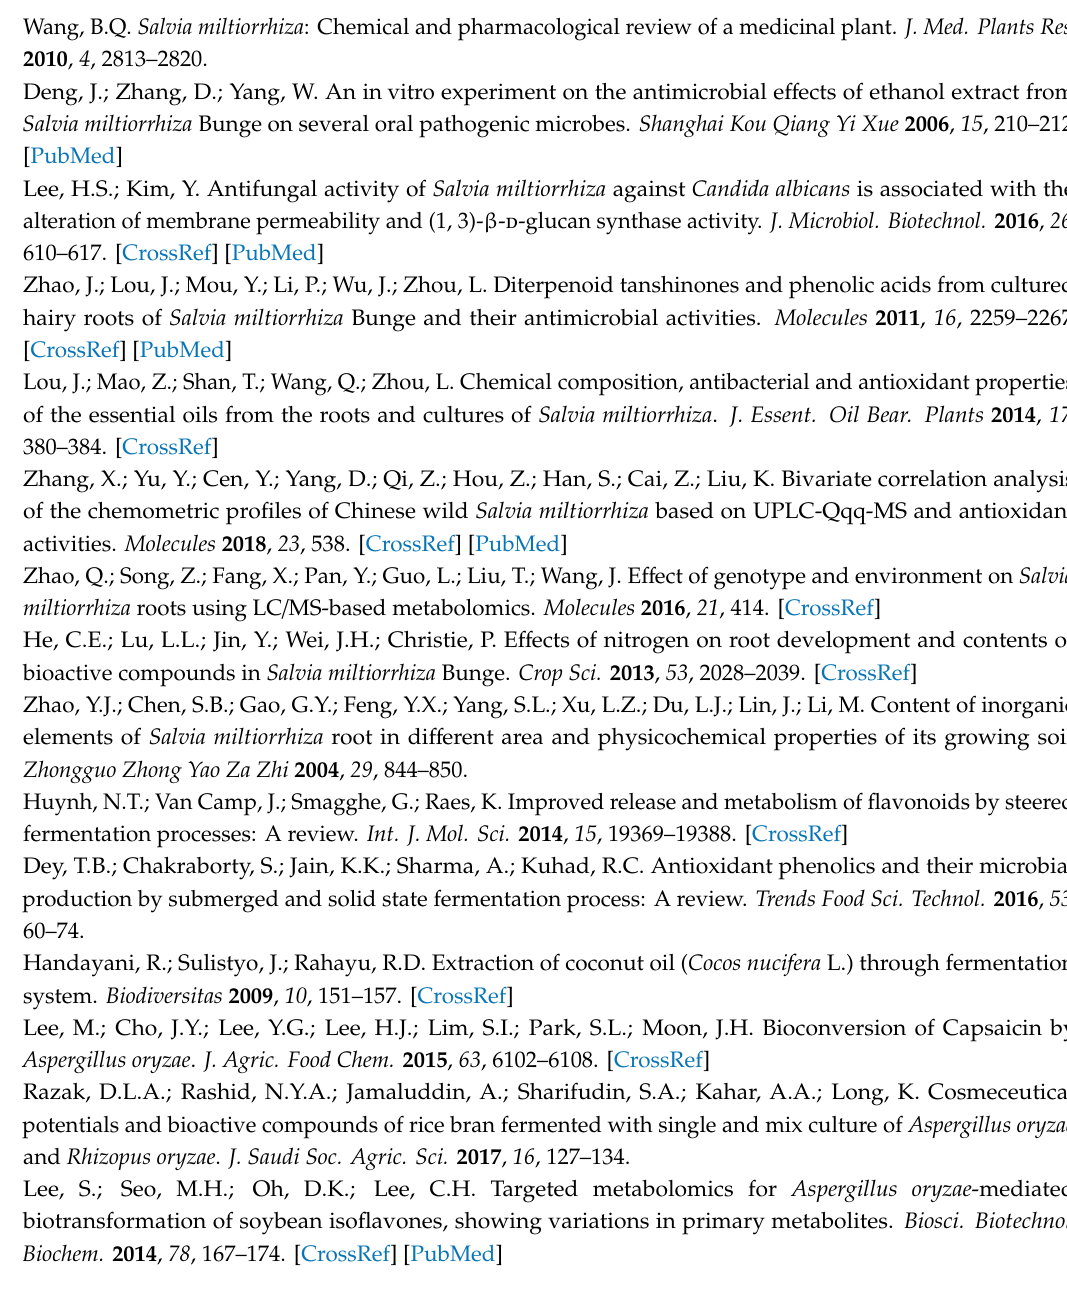
Figure S1: Sequential fractionation of EtOH extract with organic solvents. Figure S2: LC-MS chromatogram of SME (A and C) and SMBE (B and D). Figure S3: GC-MS chromatogram of AoryE. Table S1: Compounds detected by GC-MS analysis of